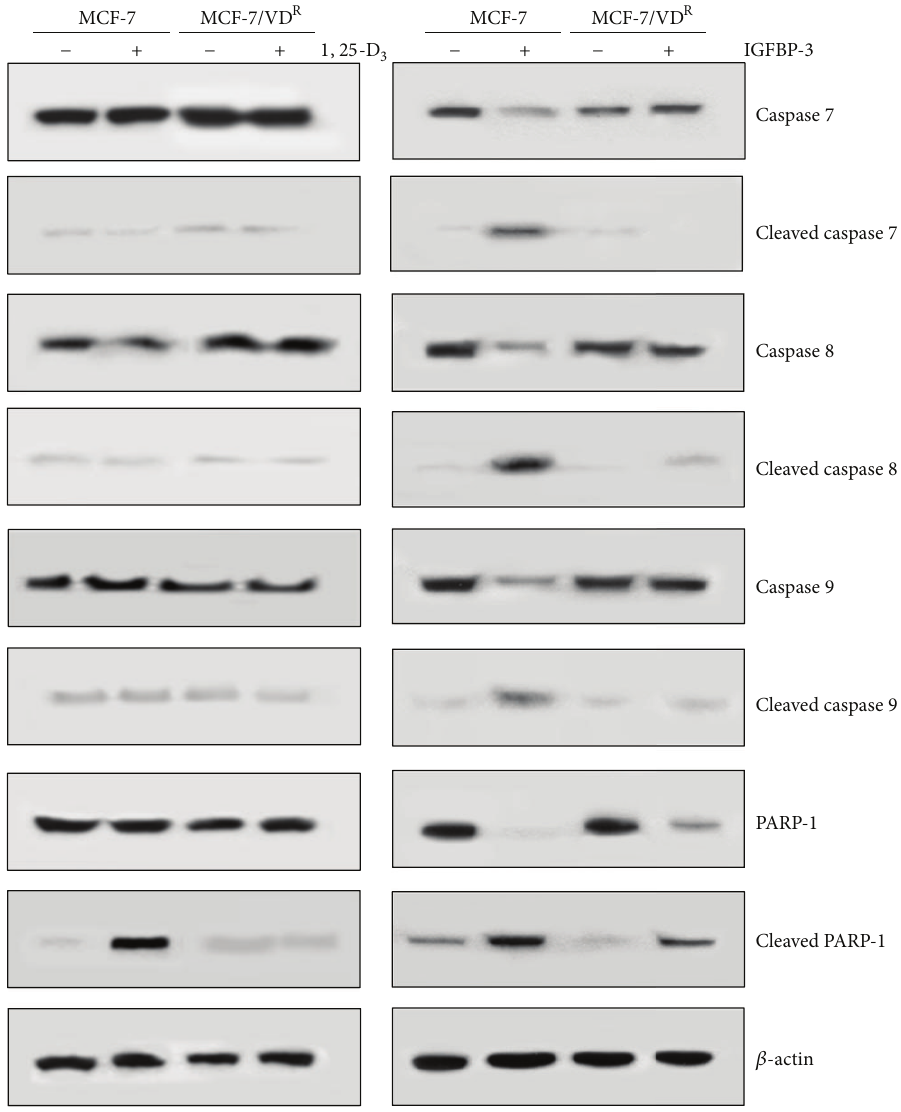
Figure 2: Caspase activation in response to 1, 25-D 3 and IGFBP-3. MCF-7 and MCF-7/VD R cells were treated with 100nM 1, 25-D 3 or 0.1% ethanol as vehicle control for 5 days (left hand panel) or 100nM IGFBP-3 for 3 days. Control cells received an equal volume of PBS diluent (right-hand panel). Whole cell extracts were prepared and analysed by immunoblotting using specific antibodies of interest and 𝛽 -actin was used as a loading control. Data shown are representative of three identical